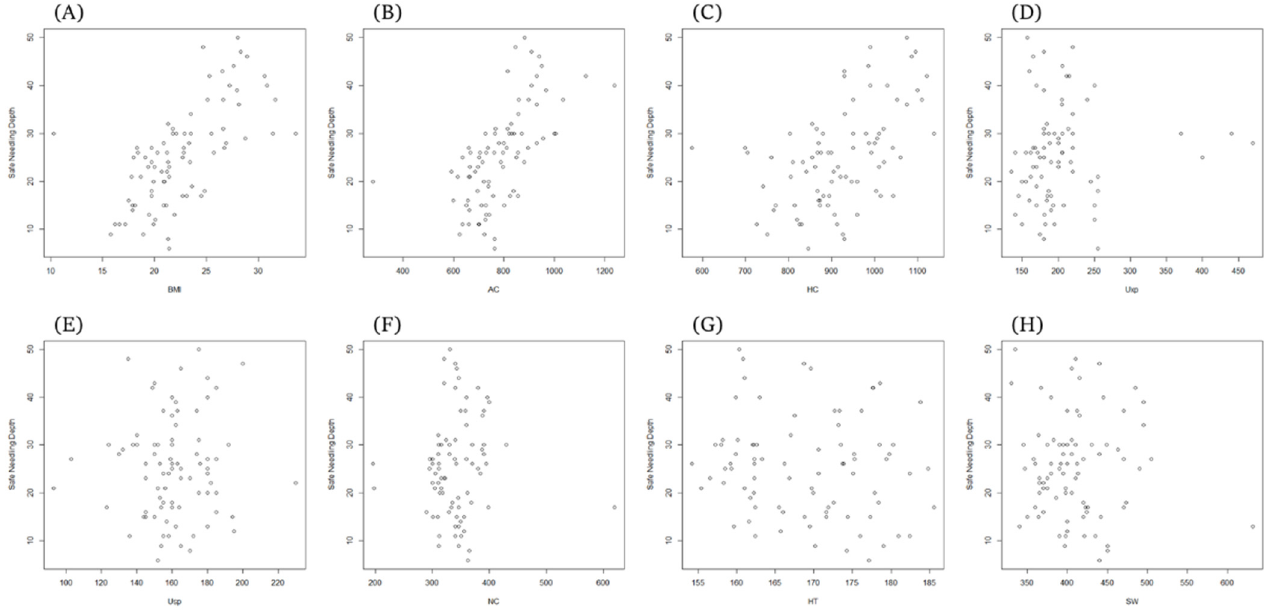
Figure 6. Scatter plot graph showing correlation (r) between needling depth (cm) and various pa- rameters. The scatter plots indicate positive trends in the relationship of all parameters on the safe needling depth. ( A ) BMI and ANIR, ( B ) AC and ANIR, ( C ) HC and ANIR, ( D ) UXp and ANIR, ( E ) USp and ANIR, ( F ) NC and ANIR, ( G ) HT and ANIR, and ( H ) SW and ANIR.